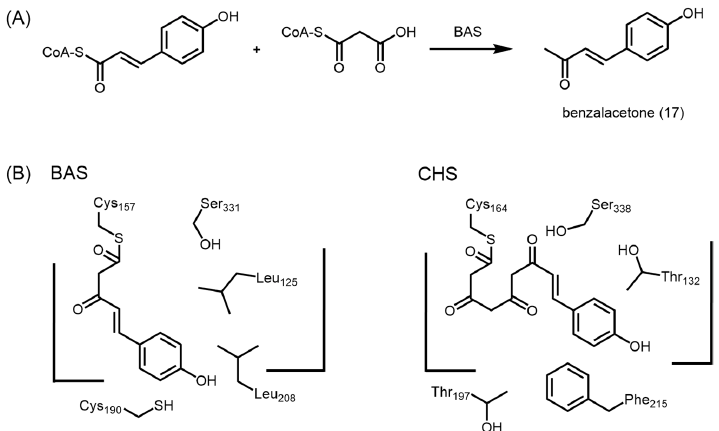
Figure 6. Comparison of the active sites of M. sativa CHS and R. palmatum BAS. ( A ) Synthesis of benzalacetone; ( B ) Schematic representations of the active site of BAS and CHS. The presence of Leu-208, Leu-125, and Cys-190 and the reorientation of Ser-331 in BAS changed the orientation of the starter acyl-CoA, p- coumaroyl-CoA, as well as the orientation of the growing polyketide intermediate, leading to the formation of